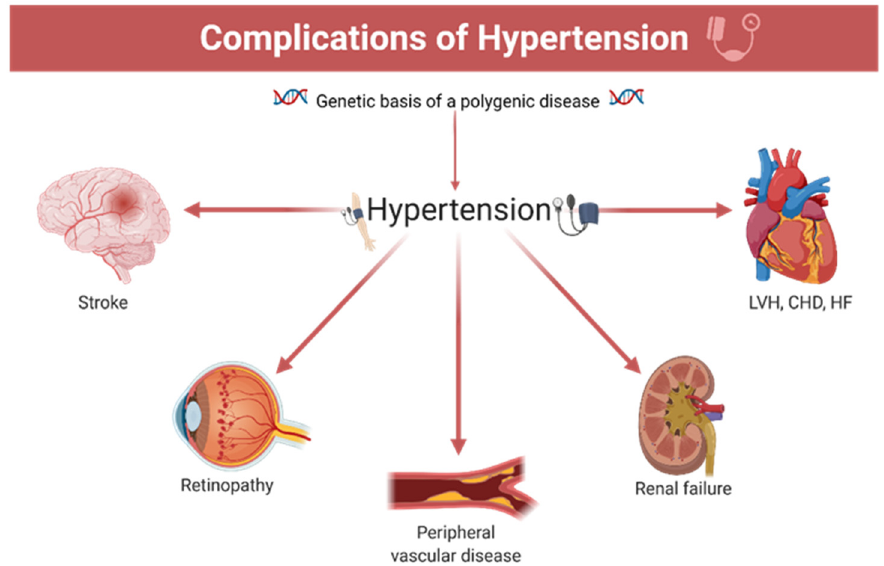
Figure 1. The main complications induced by hypertension (polygenic substrate): LVH—left ventric- ular hypertrophy; CHD—coronary heart disease; HF—heart failure.